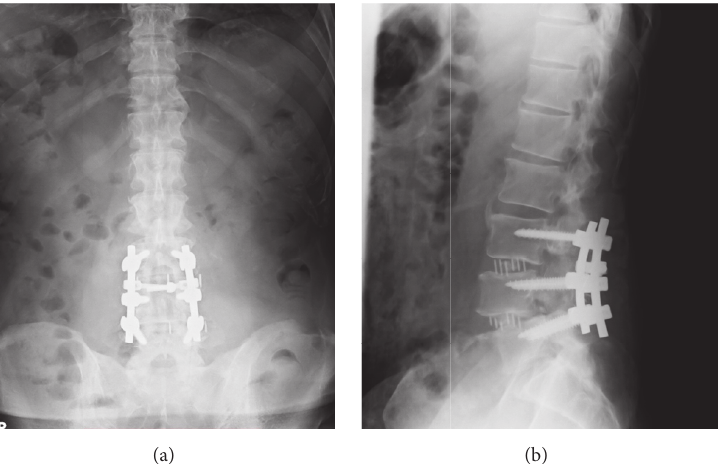
Figure 4: Postoperative radiography of the lumbar spine. AP view (a); lateral view (b). Lateral lumbar interbody fusion of L3/4 and L4/5 was performed at the initial surgery, and posterior decompression fixation using pedicle screws from L3 to L5 was performed at the second